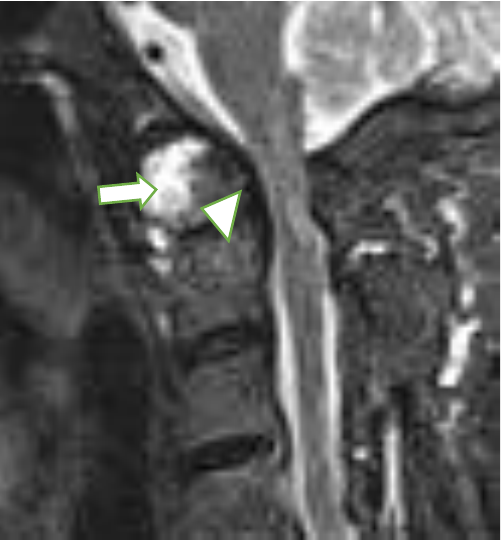
Figure 2. Sagittal MRI, T2-w TIRM image in a 65-year-old female with rheumatoid arthritis shows dens erosions (arrowhead) and periodontal effusion and pannus (long arrow). MRI: magnetic resonance imaging, TIRM: turbo inversion recovery magnitude.